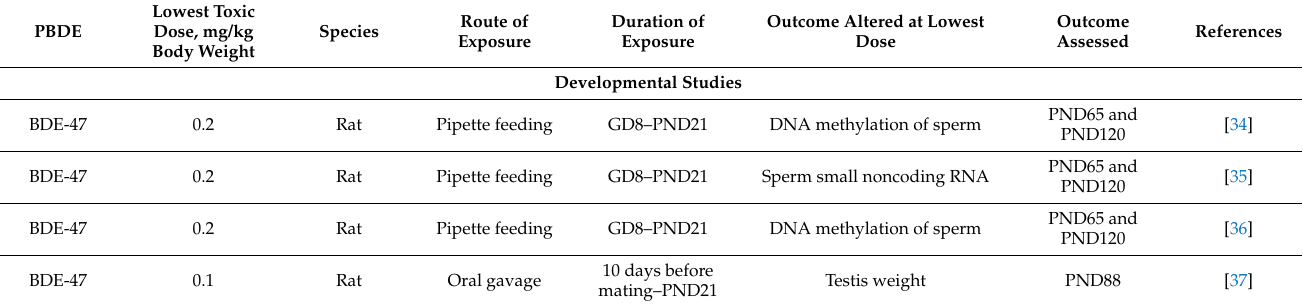
Table 2. Summary of studies assessing male reproductive toxicity of PBDE in laboratory